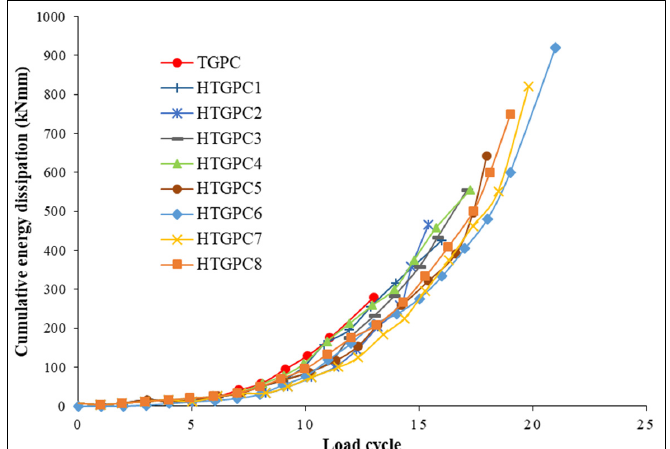
Figure 9. Cumulative energy dissipation of